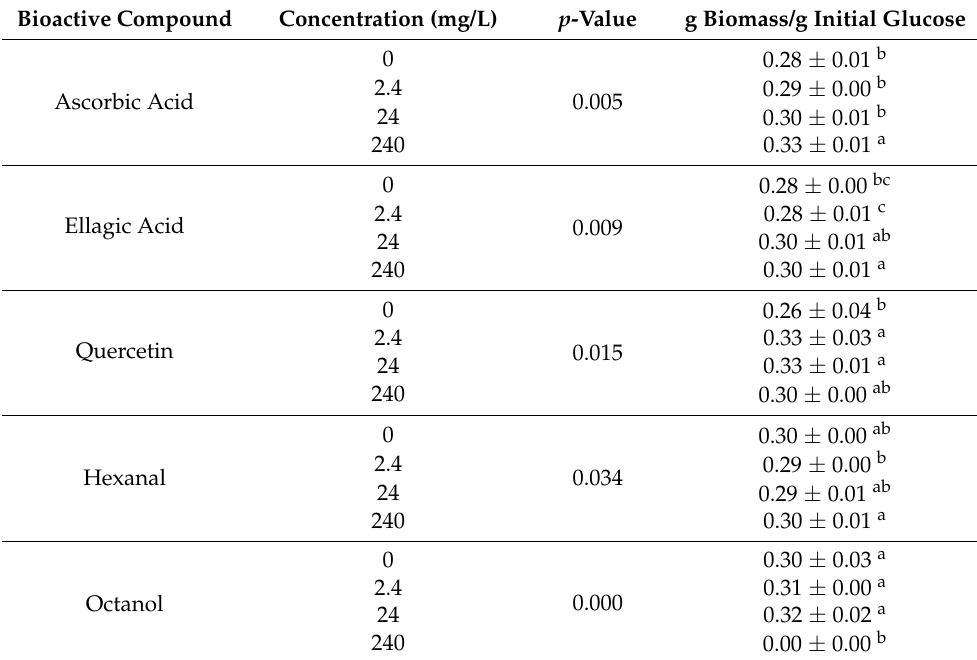
Table 3. Statistical analysis results showing significant difference between the effect of different concentrations of each bioactive compound on A. niger biomass